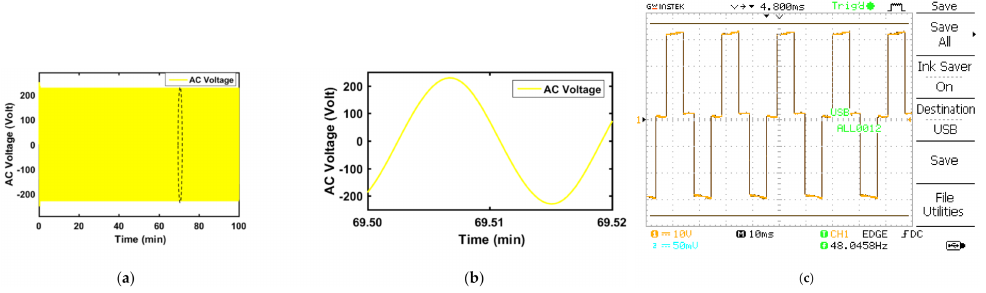
Figure 11. Experimental analysis for Day 4: 322 W / m 2 , 21 ◦ C.